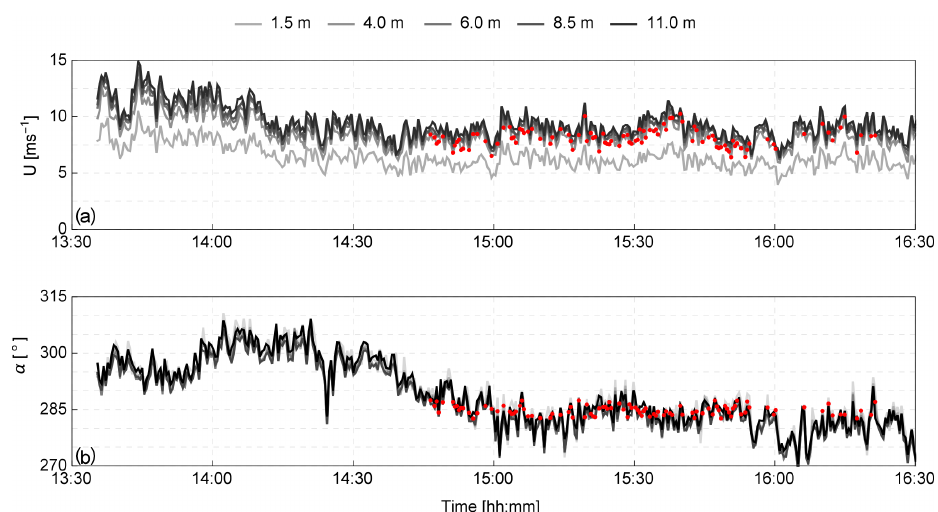
Figure A1. Time series of the 26s mean wind speed (a) and direction (b) over a period of 3h between 13:30–16:30UTC+2 on 25 October 2017. The measurements were acquired by five sonic anemometers located on the M 1 mast 1.5, 4.0, 6.0, 8.5 and 11.0m above ground level.